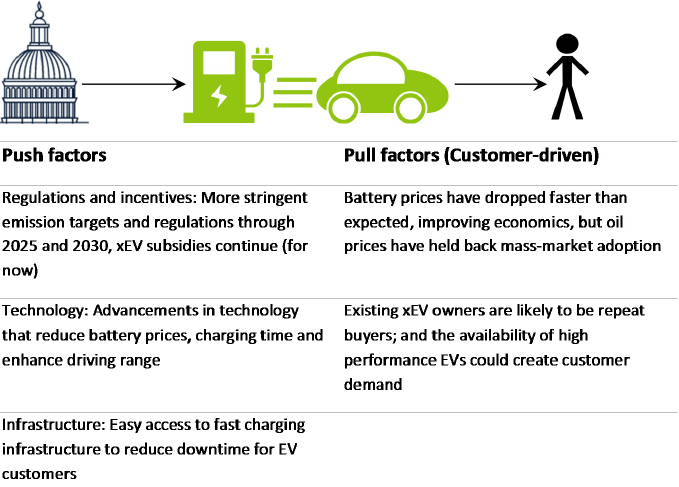
Figure 5. Roadblocks for 100% EV adoption.